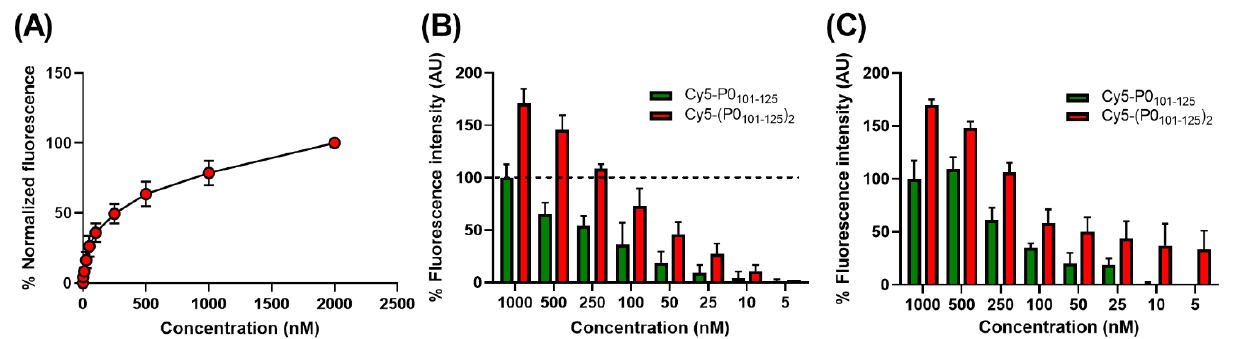
Figure 3. Quantified assessment of binding affinity and signal intensity. ( A ) Saturation binding curve for Cy5-(P0 101–125 ) 2 as determined using flow cytometry after incubation of cells with increasing tracer concentrations (0–2000 nM). ( B ) Quantification via flow cytometry and ( C ) via fluorescence confocal microscopy of the fluorescence intensity per cell for Cy5-P0 101–125 (green bars) and Cy5-(P0 101–125 ) 2 (red bars) at different tracer concentrations.